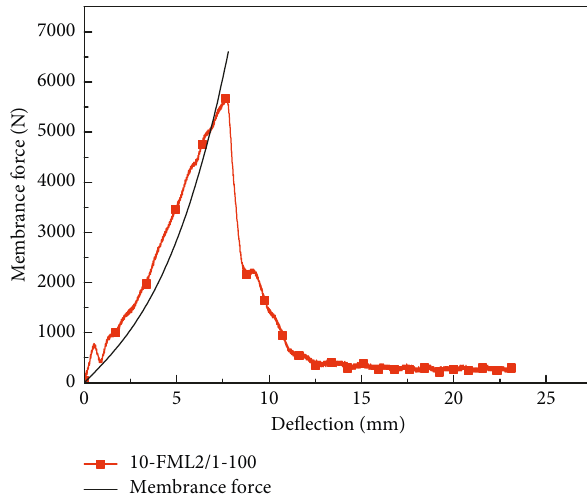
Figure 6: Load-deflection relation of the thin BFML plate con- trolled by membrane